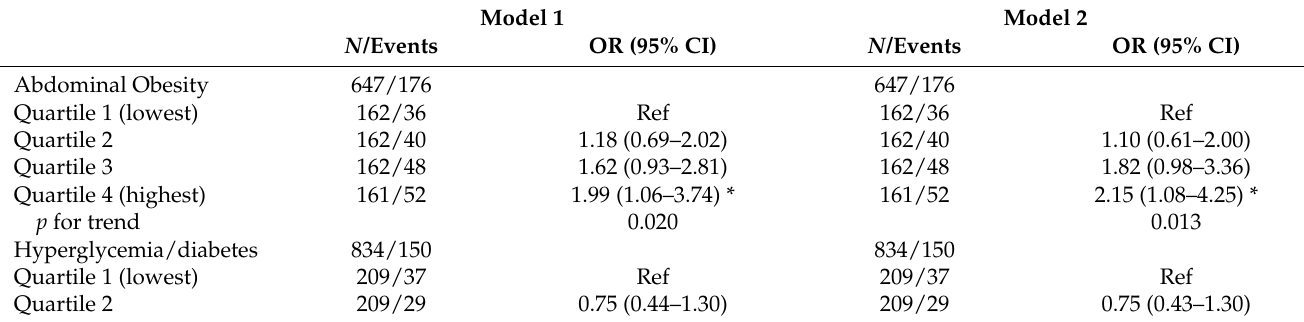
Table 5. Odds ratios (95% confidence interval) for the incidence of each component of metabolic syndrome according to sex-specific quartiles of percentage of energy intake at dinner among participants in the Seniors-ENRICA-1 cohort study (2008/10 to